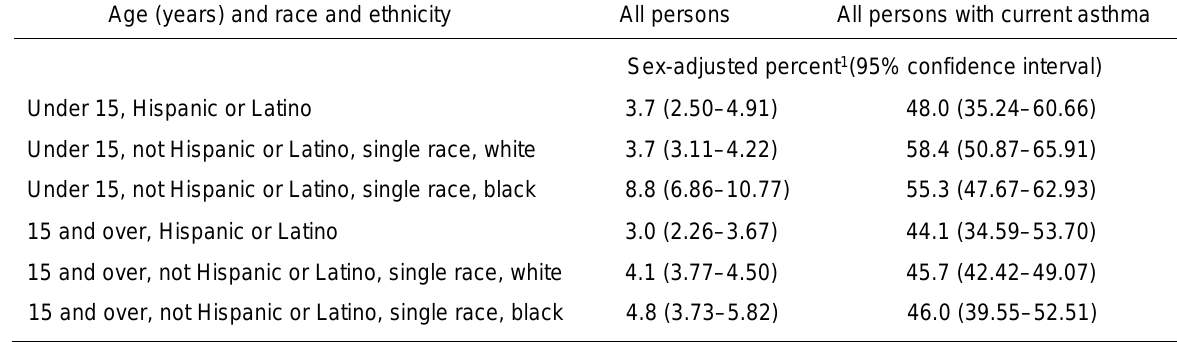
Data table for Figure 15.3. Sex-adjusted percentage of persons of all ages who experienced an asthma episode in the past 12 months, by age group and race